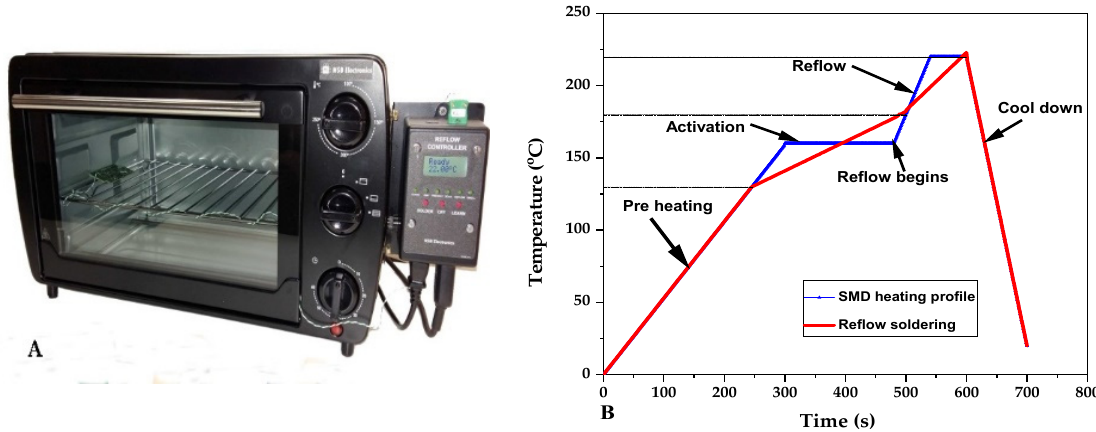
Figure 3. Bench top of the reflow oven ( A ), temperature profile of the reflow oven ( B ).